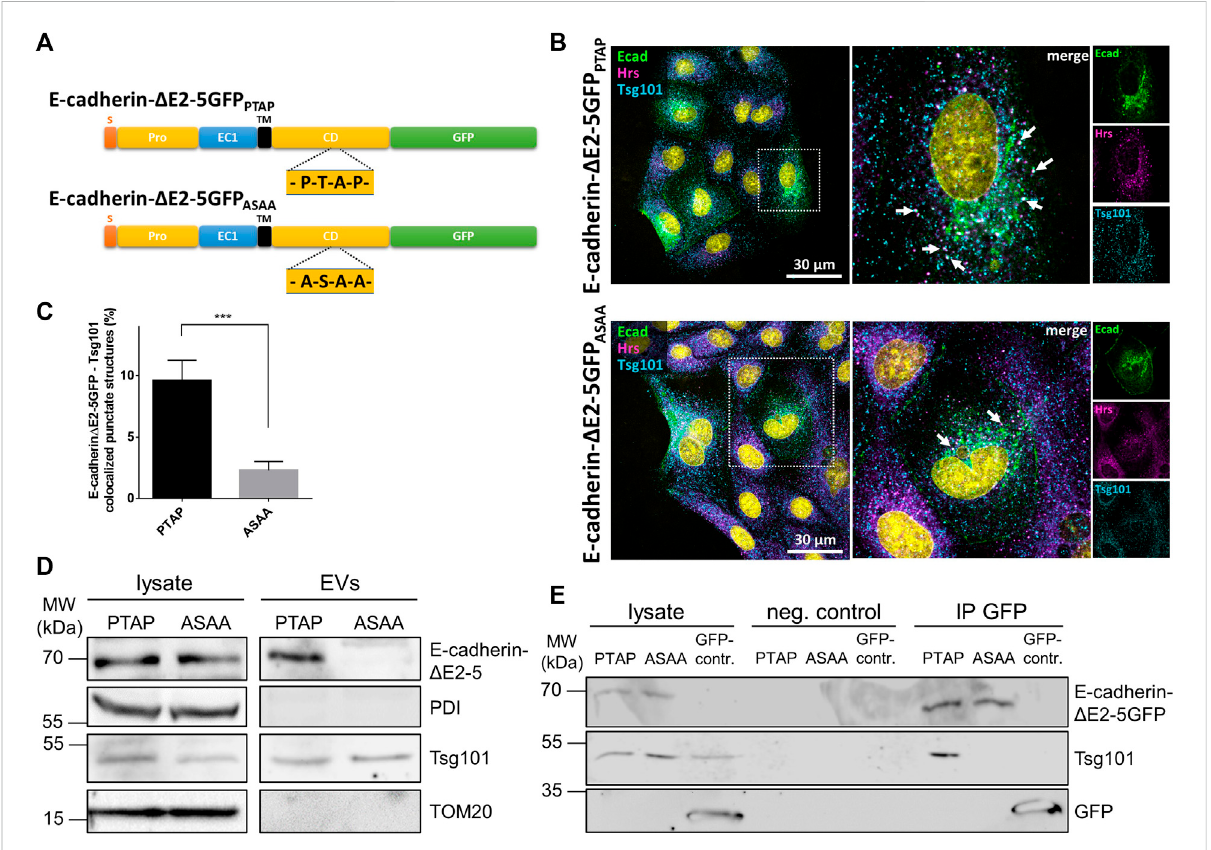
FIGURE 5 Subcellular localization and EV recruitment of E-cadherin variants. (A) Schematic drawing of the two E-cadherin deletion constructs. S, signaling sequence; pro, pro-domain; EC, E-cadherin domain; TM, transmembrane domain; CD, cytoplasmic domain. The location of the PTAP late domain motif and the mutagenized ASAA stretch are indicated. (B) Confocal codistribution analysis of MDCK cells transiently transfected with E-cadherin Δ E2-5GFPorE-cadherin Δ E2-5GFP ASAA withtheMVE-proteinsHrsandTsg101.Thecellswerecultivatedfor2 daysposttransfection, fi xedandstainedbyimmuno fl uorescencewithmAbanti-Tsg101/AlexaFluor555andpAbanti-Hrs/AlexaFluor647.Enlargedviewsofareasencircled bydottedlinesaredepictedontheright.Nucleiaredepictedincyan.Vesicularstructuresco-stainedforE-cadherin,Hrs,andTsg101areindicatedby arrows. (C) Colocalization of the two E-cadherin Δ E2-5GFP variants and Tsg101 was estimated from at least 15 cells per experiment via the Manders ’ colocalization coef fi cient. Data are represented as means ± s.e.m., signi fi cance was tested with Student ’ s t -test (*** p < 0.001), n = 3 independent experiments. (D) EVs isolated from MDCK E-cadherin Δ E2-5GFPPTAP (PTAP) and MDCK E-cadherin Δ E2-5GFPASAA (ASAA) culture media and the corresponding cell lysates were analyzed by immunoblot using antibodies directed against E-cadherin and Tsg101. Antibodies directed against PDI and TOM20 were used as negative controls to validate the purity of EV-isolation. (E) Co-immunoprecipitation of E-cadherin variants with Tsg101 from MDCK E-cadherin Δ E2-5GFPPTAP (PTAP) and MDCK E-cadherin Δ E2-5GFPASAA (ASAA) cell lysates. E-cadherin Δ E2-5GFP or E-cadherin Δ E2-5GFP ASAA and their binding partners were immunoprecipitated with GFP-nanobody beads and detected by immunoblot using antibodies directed against GFP